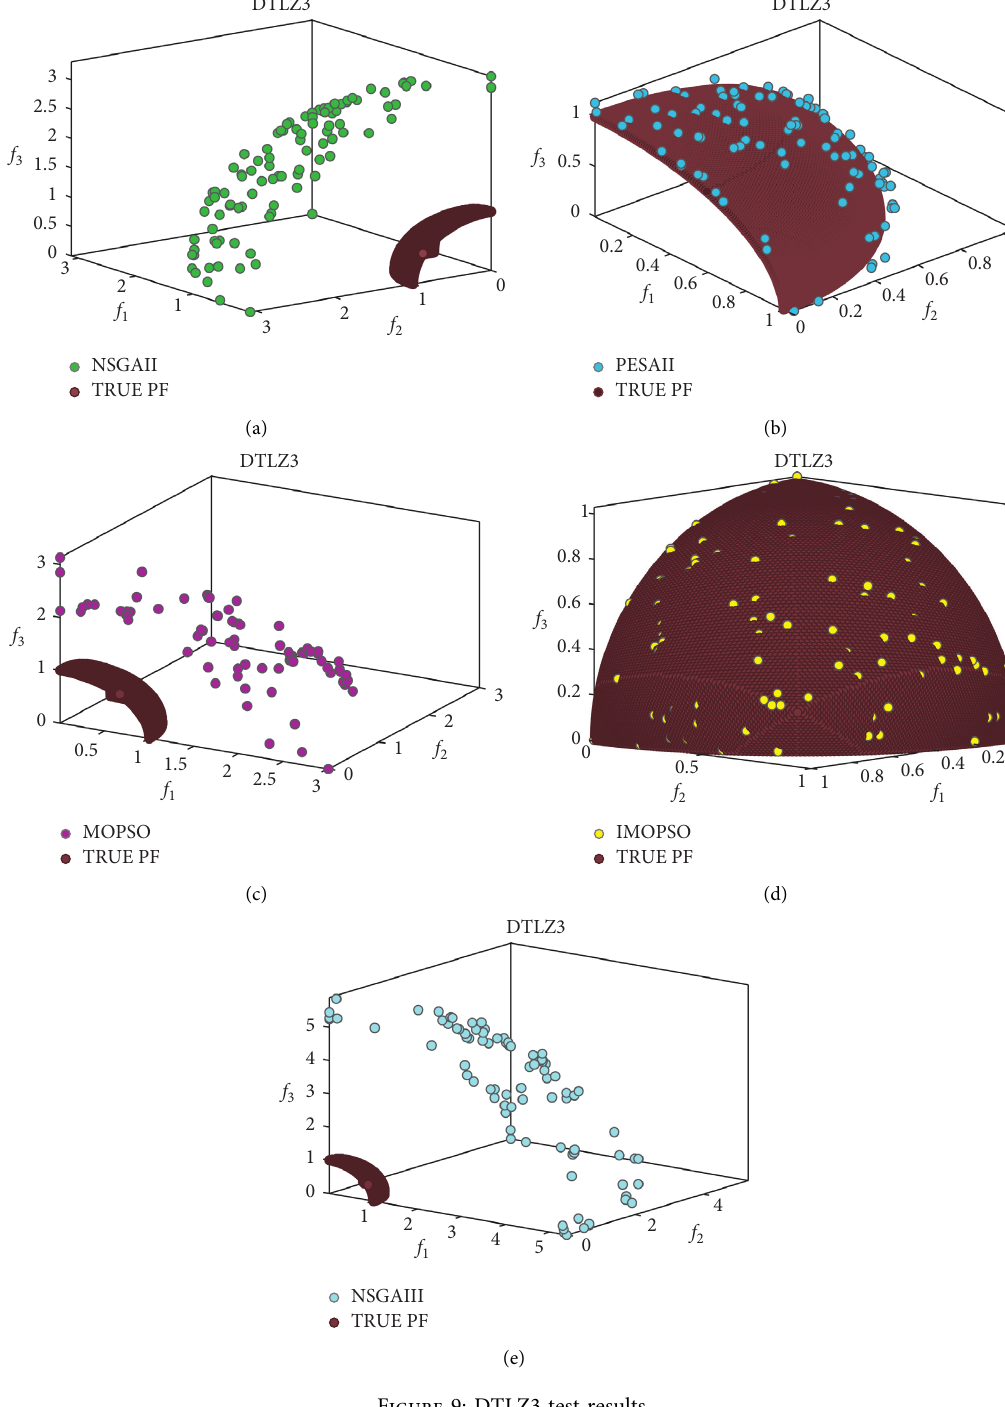
Figure 9: DTLZ3 test